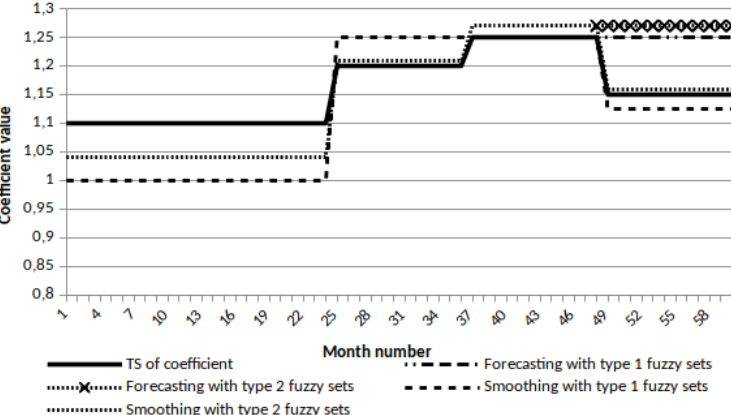
Figure 13. Approximation and forecasting of the time series of the production